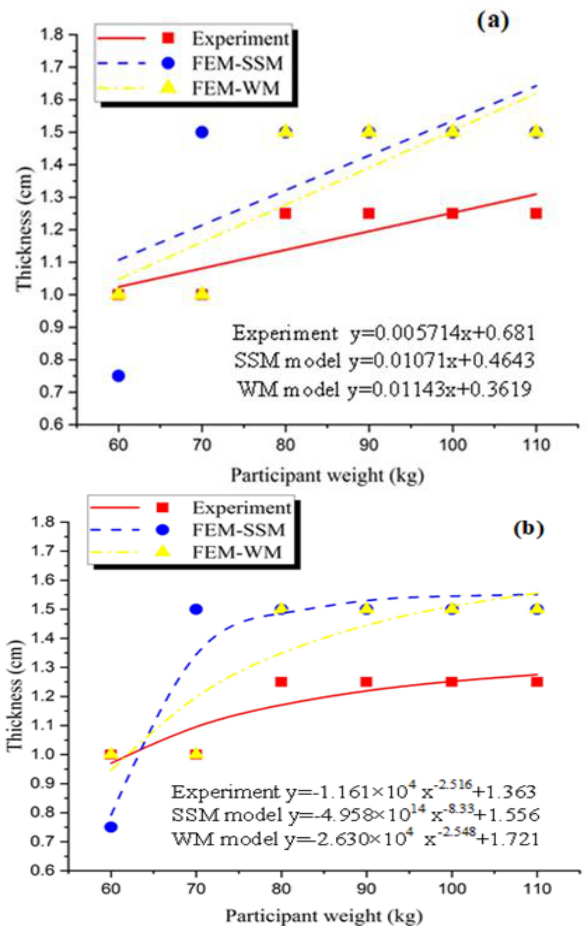
Figure 9. Graph between the weight of the patient against the appropriate thickness; ( a ) is polynomial and ( b ) is power. Table 6. Comparison between thicknesses based on mathematical model by polynomial fit.